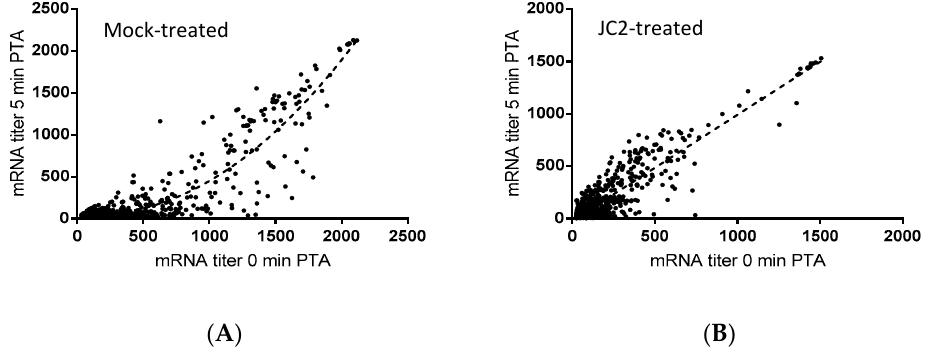
Figure 4. Microarray transcriptomic analysis of DMSO-treated ( A ) and 0.5× MIC JC2-treated ( B ) S. aureus UAMS-1 cells. mRNA titer levels at 0 min ( X -axis) and 5 min ( Y -axis) post-transcriptional arrest with rifampin. Best-fit curve represented by dashed line.